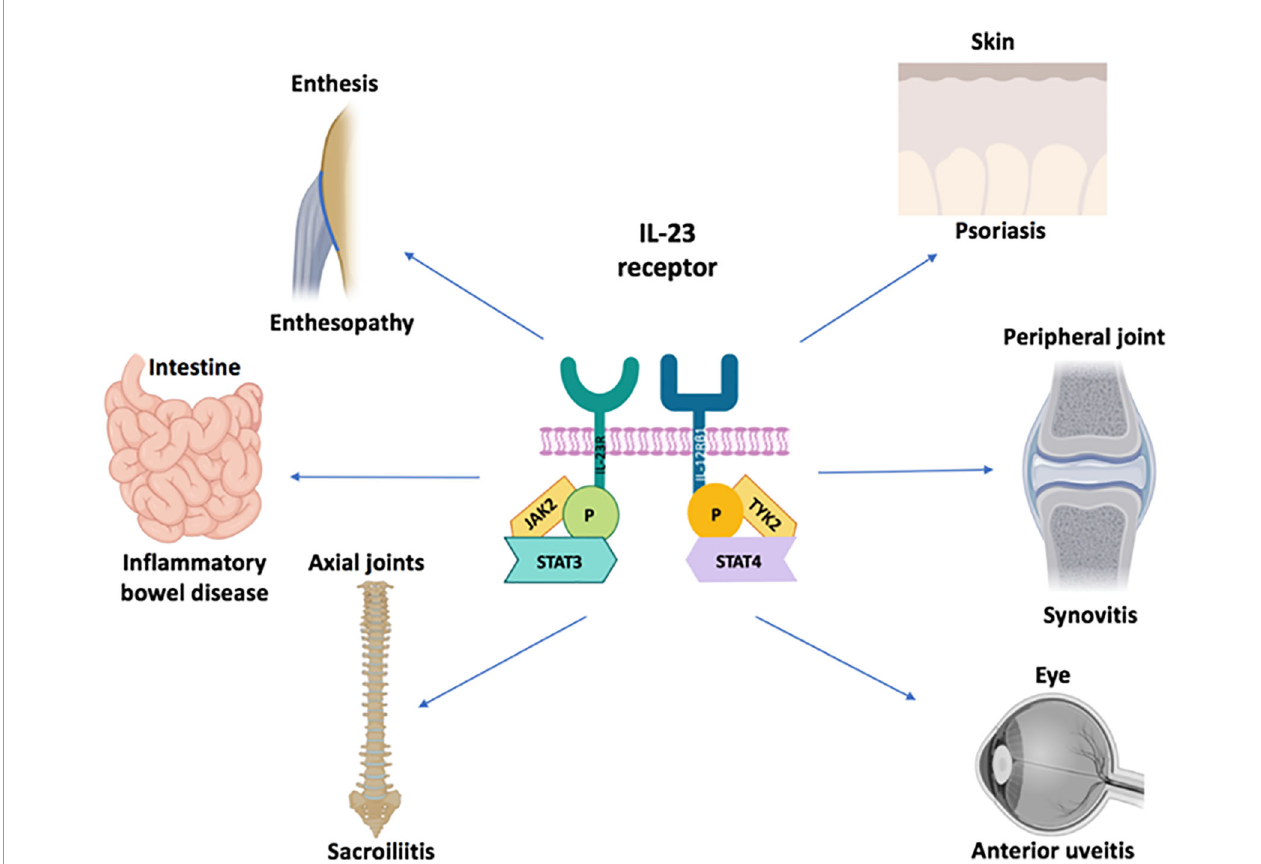
FIGURE 1 | IL-23 receptor polymorphism associated disorders. The IL-23 cytokine pathway has been fi rmly linked to ocular, cutaneous, intestinal disease and arthropathy at the genetic and cellular immunology level. There is considerable immunological heterogeneity in different organ responses. For example, the TNF-Fc fusion protein, etanercept does not work for IBD and is generally not effective for anterior uveitis. The role of IL-23 blockers for anterior uveitis awaits further de fi nition but it is generally considered that anti-IL-17A blockers are not effective in this SpA domain All the agents of that antagonise the IL-23/17 axis show remarkable ef fi cacy for psoriasis compared to joint disease. With respect to gut disease, the IL-17 blockers have an important role in barrier function at this site which may explain exacerbations of IBD under anti-IL-17A therapy. All three cytokines including TNF, IL-17A and IL-23 may be equally important for peripheral arthritis in PsA and also for enthesitis in the peripheral skeleton because good responses are seen following therapeutic antagonism. The anti-p40 IL-12/23 may be less effective than the other three categories of drugs for Psoriatic arthritis although further studies are needed. Finally, only TNF and IL-17 blockers have shown ef fi cacy in the axial skeleton where IL-23 blockade with either p40 or p19 blockers has not worked. The site-speci fi c compartmentalisation of immunity has come into sharp focus in the past few years and likely re fl ects tissue speci fi c factors and microbiota interactive factors shaping diverse immune